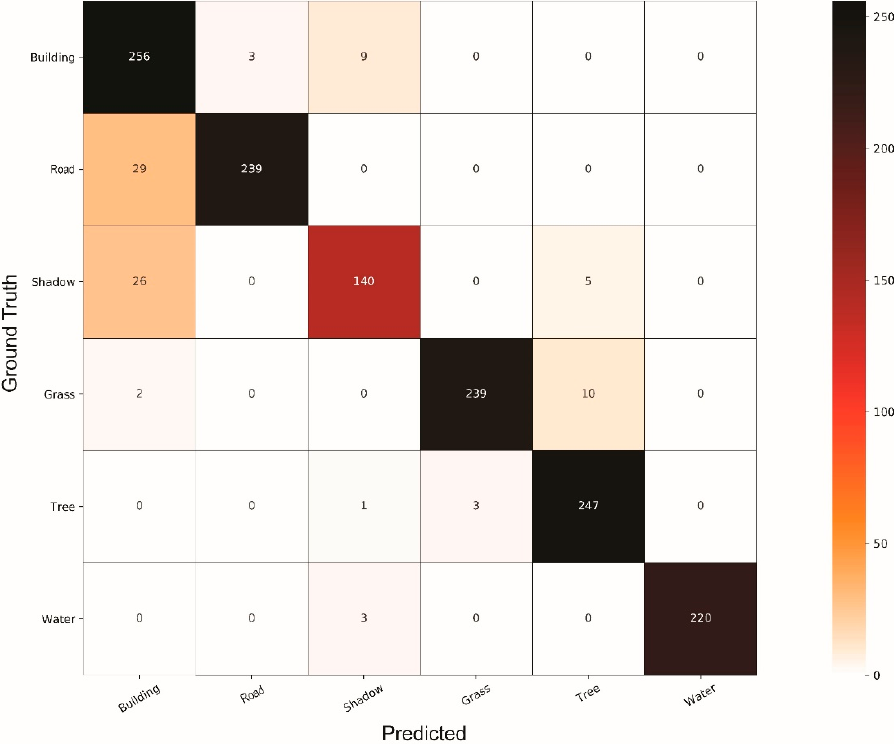
Figure A8. Confusion matrix of the MLP model for 50 cm image.